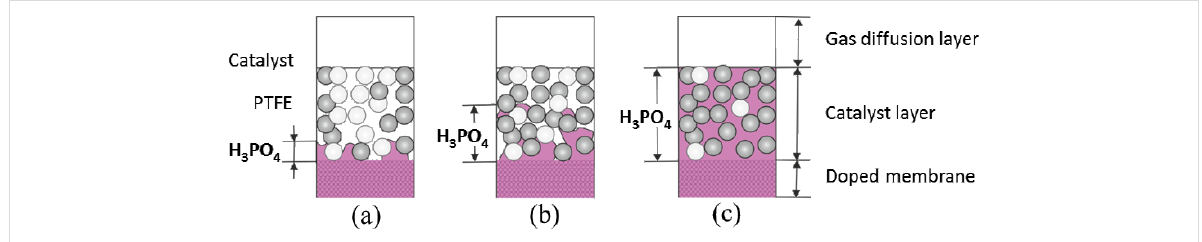
Figure 8: Schematic diagram illustrating the difference in the amount of phosphoric acid migration from the doped membrane to the catalyst layer with different PTFE content (a) high (b) medium and (c) low.